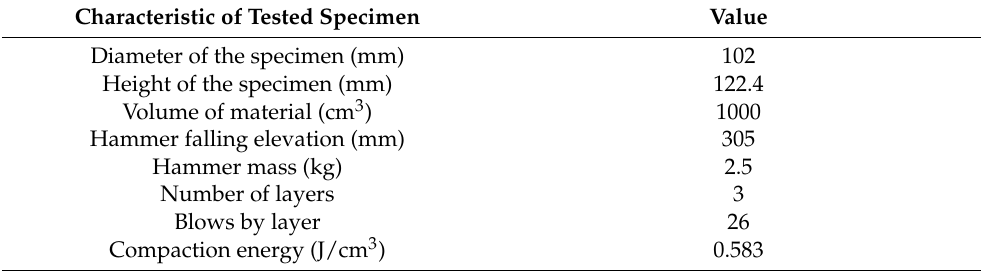
Table 3. Characteristics of compaction procedure according to standard Proctor [15]. Characteristic of Tested